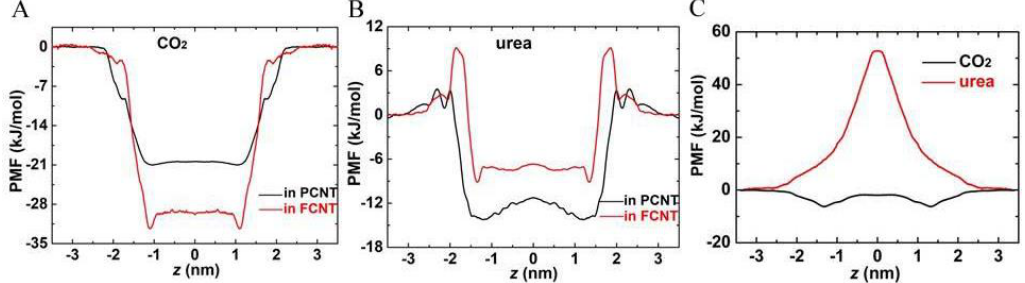
Figure 9. Potential of mean force (PMF) profiles of CO 2 and urea across the PCNT, FCNT, and lipid bilayer. ( A ) PMF profiles of CO 2 across the PCNT and FCNT. ( B ) PMF profiles of urea across the PCNT and FCNT. ( C ) PMF profiles of CO 2 and urea across the lipid bilayer. The reference point of zero potential energy was set at z = 3.5 nm, where the interactions between CO 2 /urea and CNTs can be ignored.